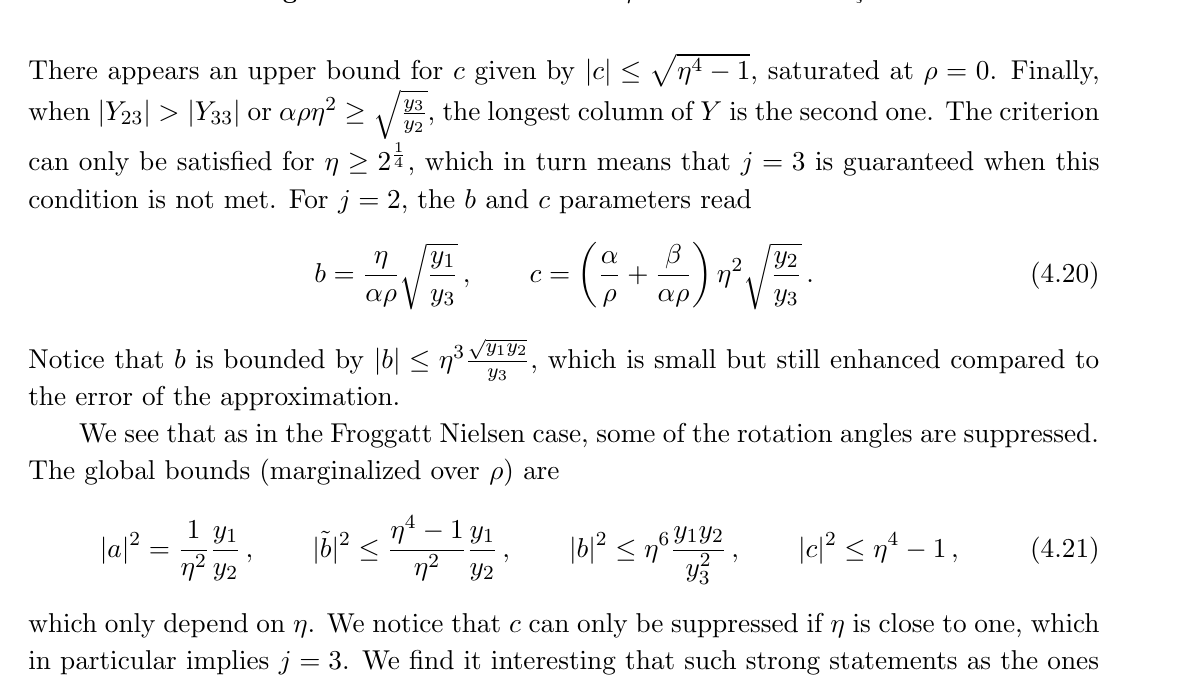
Figure 2 . The functions (cid:11) and (cid:11)(cid:26) (cid:6) 1 as a function of (cid:24)